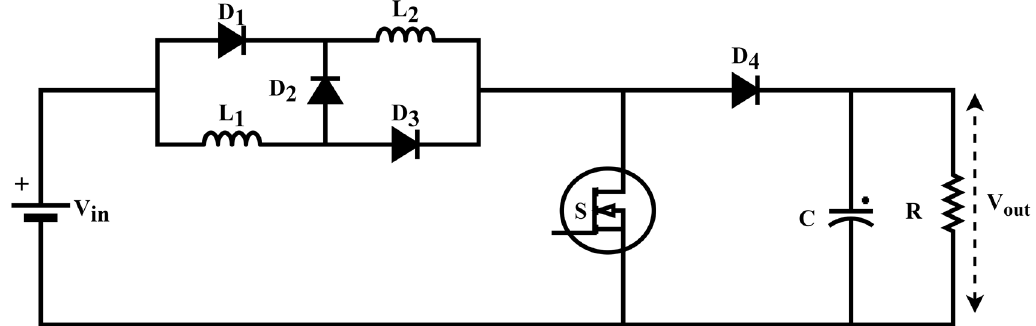
Figure 1. Existing SI-based QZS step-up converter topology.